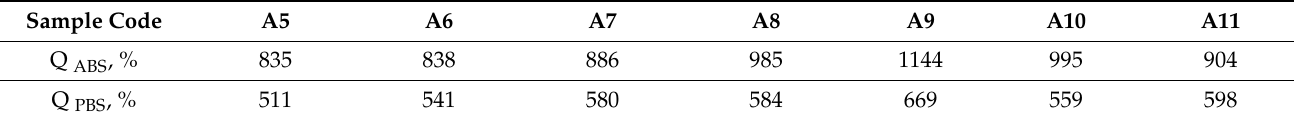
Figure 7. Chitosan particulate hydrogels (A9 sample) pH-dependent water uptake in pH = 3.3 and pH = 7.4 (PBS). (ABS) and pH = 7.4 (PBS). Table 2. Maximum water uptake of A5–A11